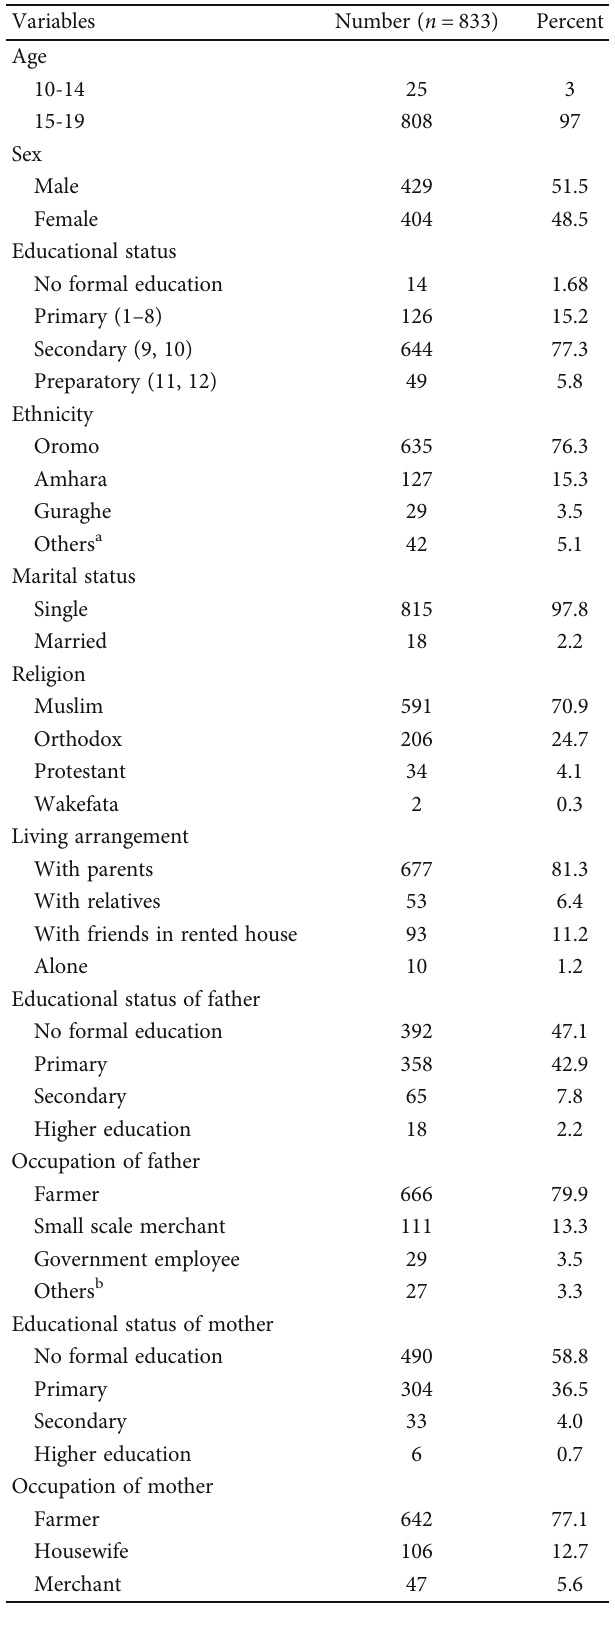
Table 1: Sociodemographic characteristics of adolescents and